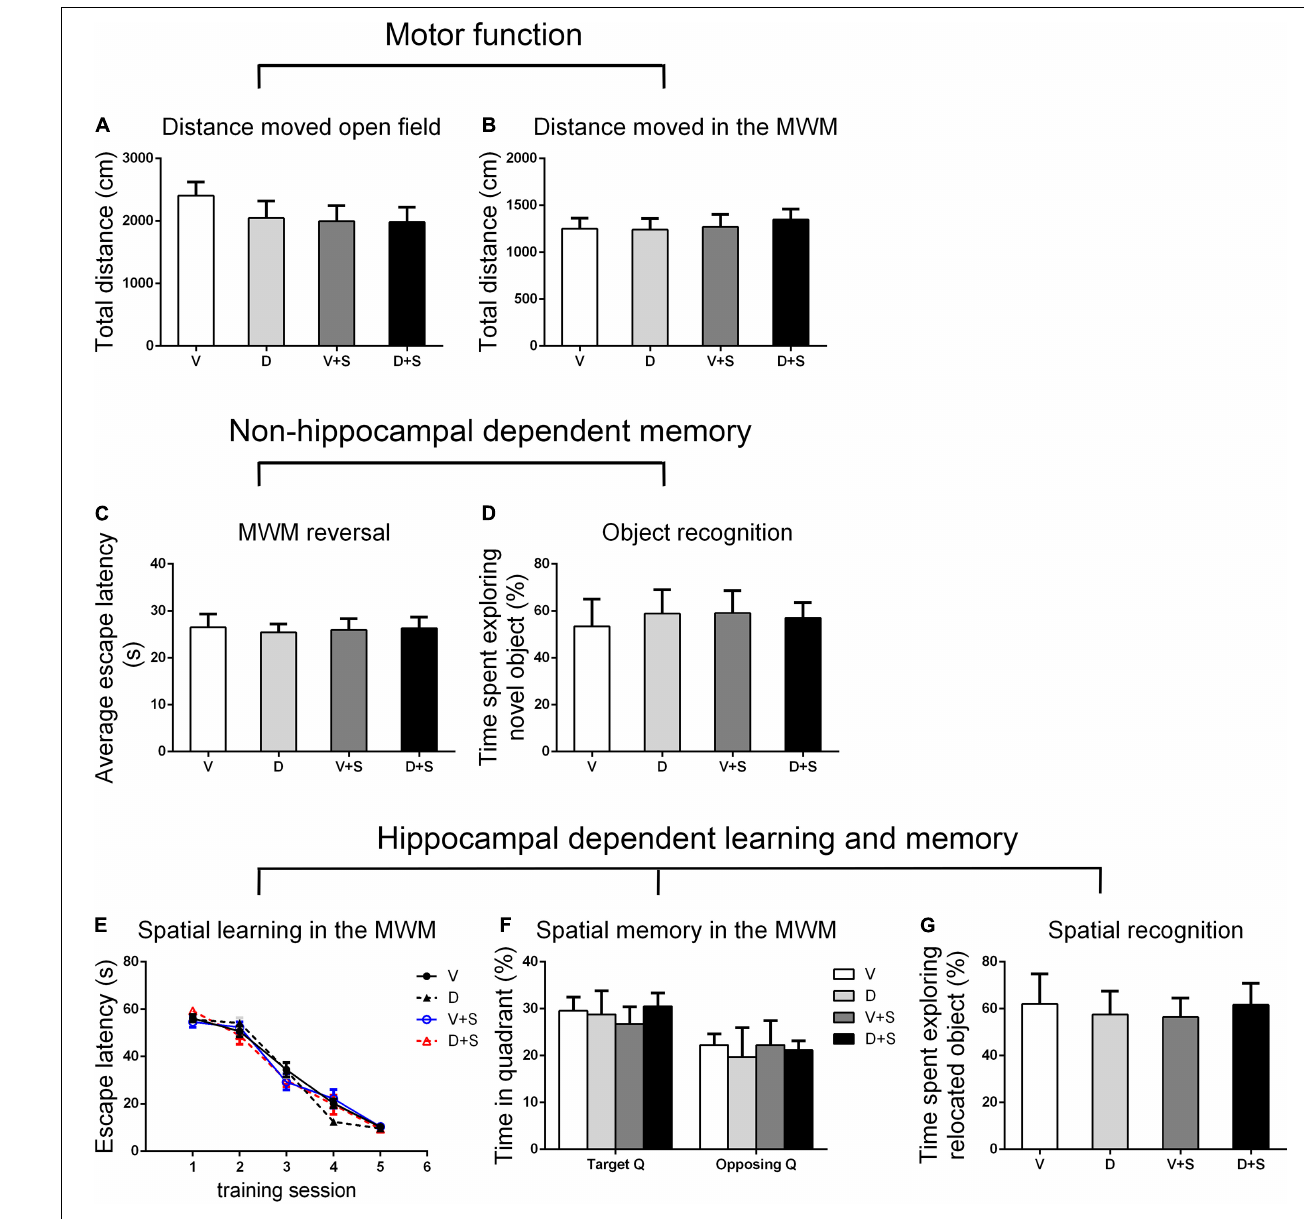
FIGURE 5 | Open field behavior, learning, and memory performance in the four groups at 3 weeks postoperatively. (A) Distance moved in the open field test (cm). (B) Distance moved (cm) in the MWM during the first test as a measure of motor function. (C) Cognitive flexibility in the MWM. Average escape latency (s) during the four MWM reversal trials. (D) Object recognition in the NO test. (E) Spatial learning in the MWM. Average escape latency (s) is shown for the five training sessions in the maze. (F) Spatial memory in the MWM. The percentages of time in the target quadrant (Target Q) and time in the quadrant opposite to the target quadrant (Opposing Q) are shown. (G) Spatial recognition in the NL test. Exploration time of the relocated object as a percentage of total object exploration is shown. The data are presented as the means ± SEM for each group ( n = 10 per cohort). * p < 0.05 compared to Group V, # p < 0.05 compared to Group V +